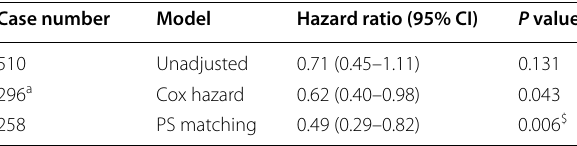
Table 3 Hazards ratio analysis in patients treated with combination